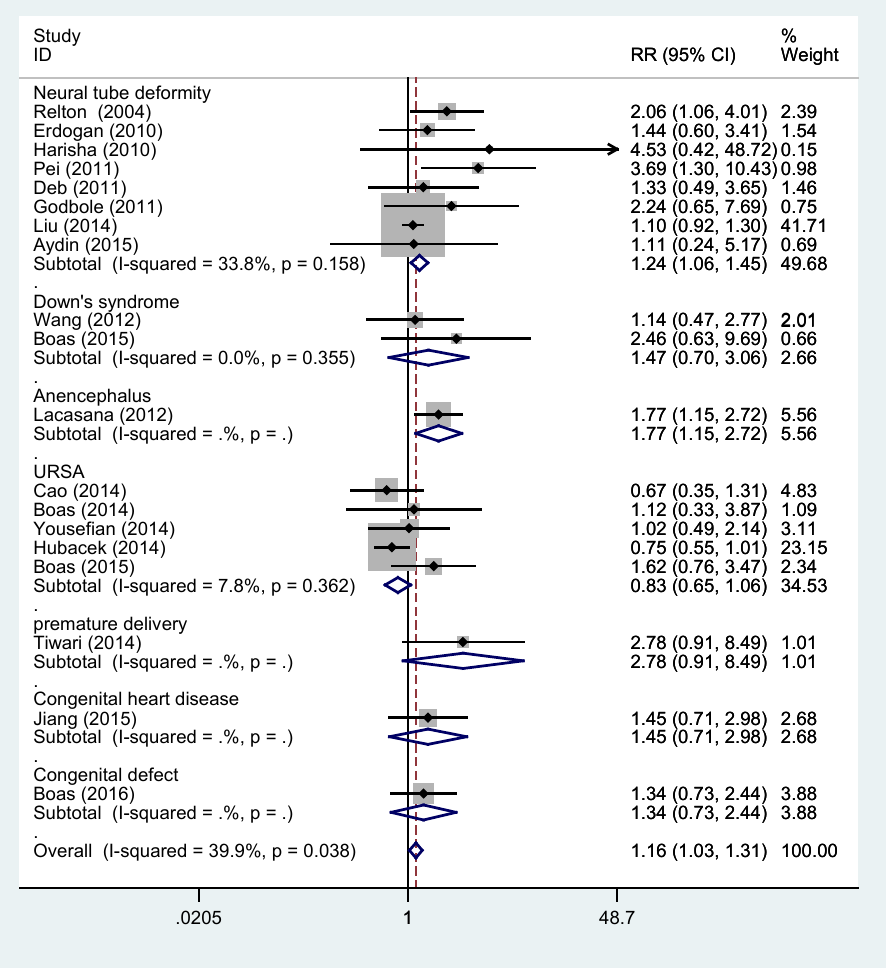
Figure 4: Forest plot of the methylenetetrahydrofolate reductase gene 677C > T polymorphism and fetal congenital defects in a recessive genetic